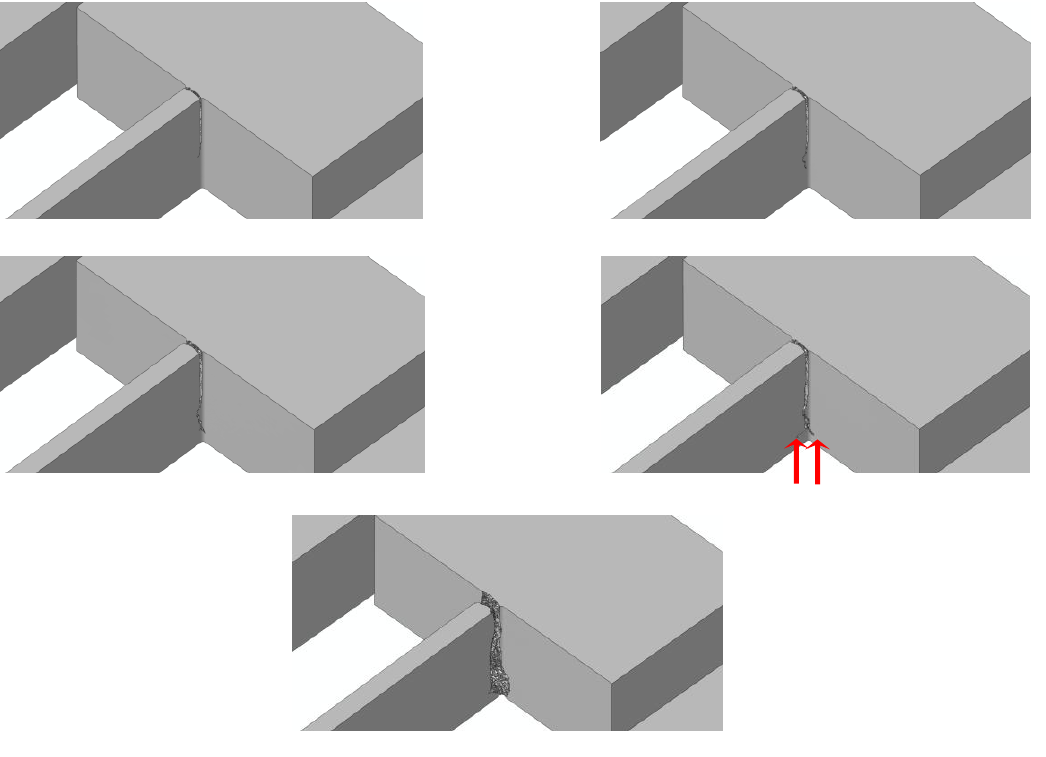
Figure 12. Top drop, d